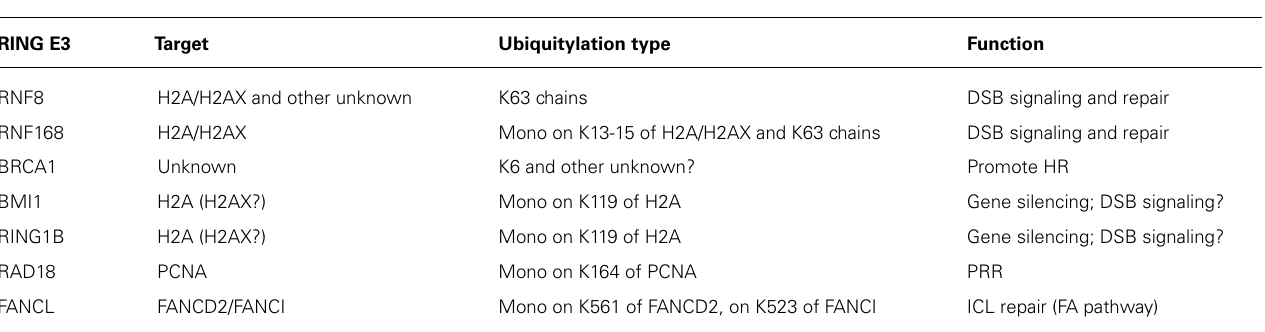
Table 1 | RING finger E3s involved in DDR